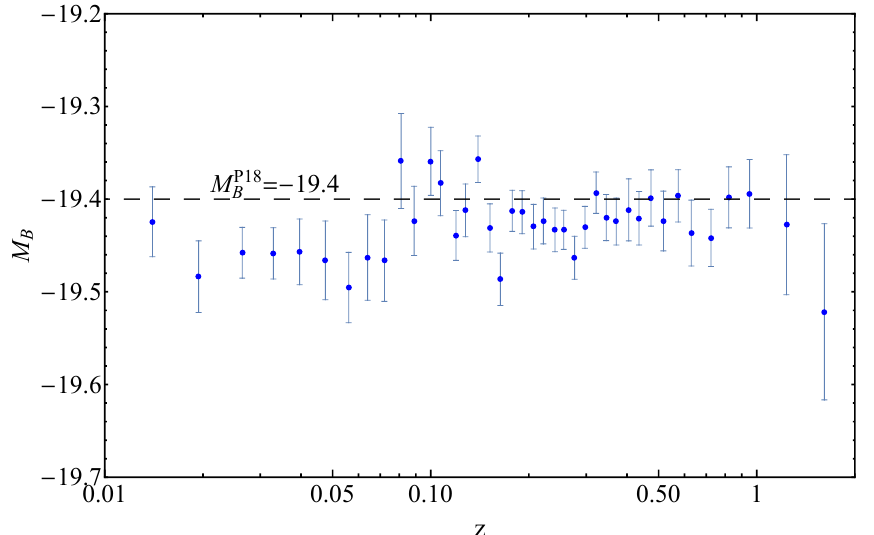
Figure 14. Plot of the inferred SNIa absolute magnitudes M B , i = m B , i − µ ( z i ) of the binned Pantheon data [5] under the assumption of a Planck/ Λ CDM luminosity distance. Furthermore, there is a = − 19.4, which is the value of the SNIa absolute magnitude calibrated straight line at the value: M p 18 B via BAO and CMB measurements found in: